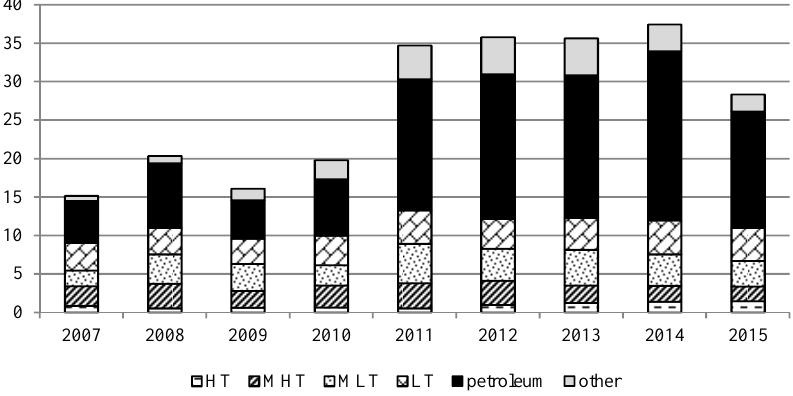
Source: own elaboration based on United Nations Commodity Trade Statistics